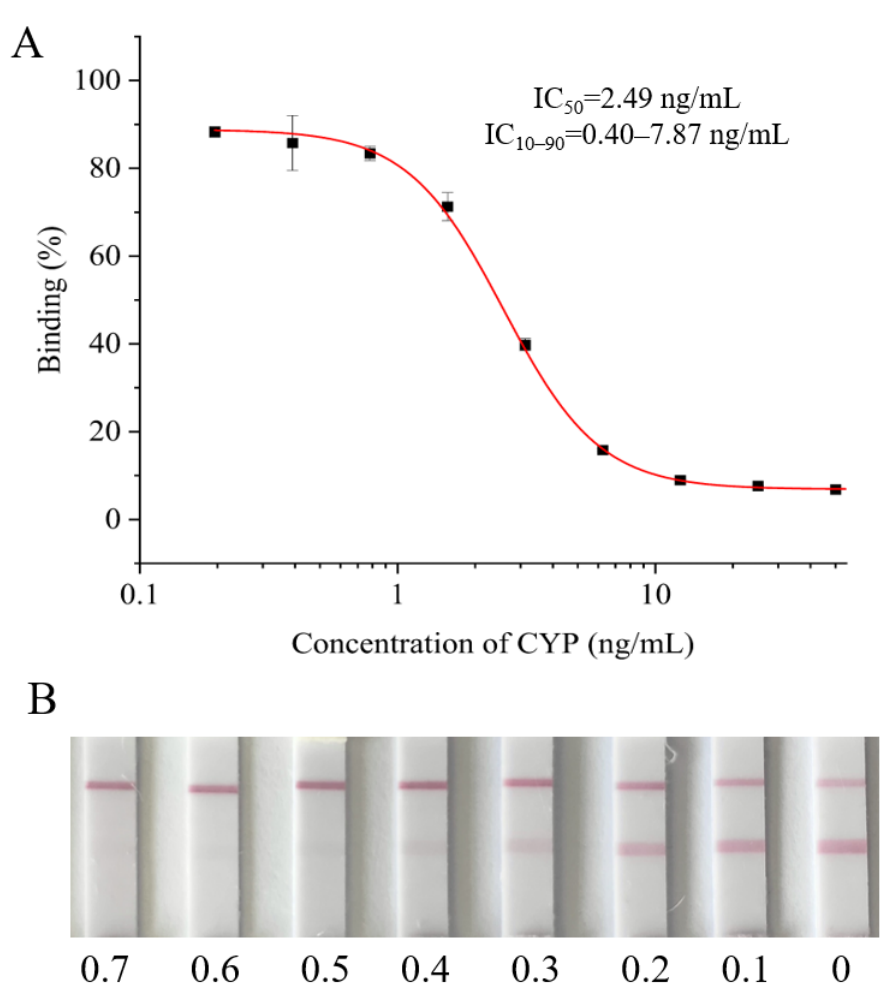
Figure 2. The sensitivity of ic-ELISA and LFIA. ( A ) The standard curve of ic-ELISA for CYP deter- mination. ( B ) The sensitive analysis of LFIA; the concentrations from left to right are 0.7, 0.6, 0.5, 0.4, 0.3, 0.2, 0.1 and 0 μg/mL.